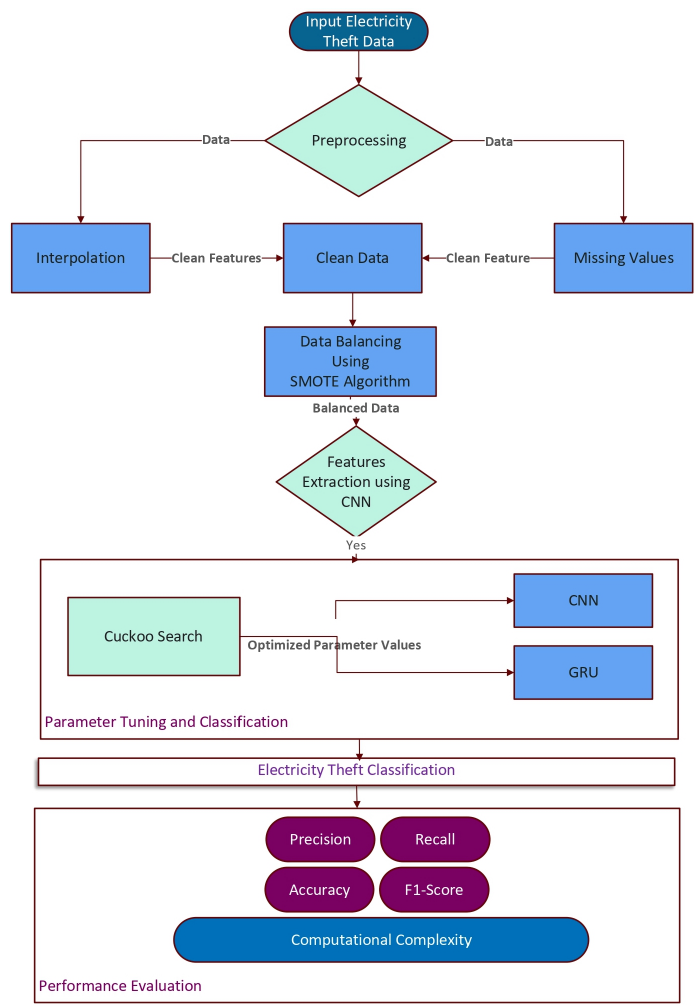
Figure 1. Detailed flowchart of System